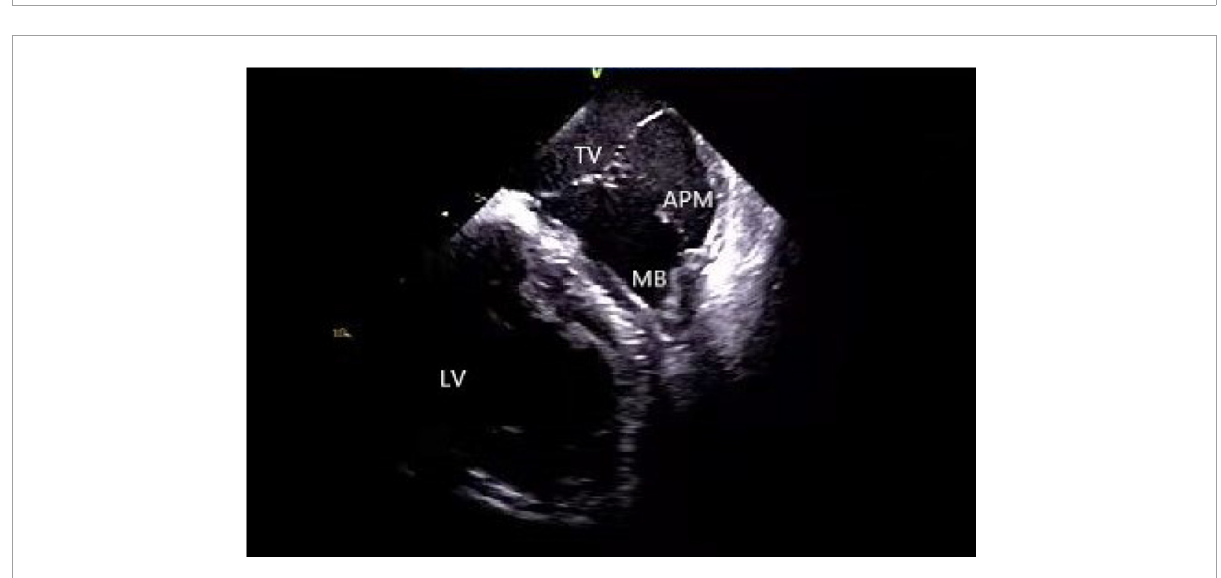
FIGURE8 Moderator band. TV, tricuspid valve; LV, left ventricle; APM, anterior papillary muscle; MB, moderator